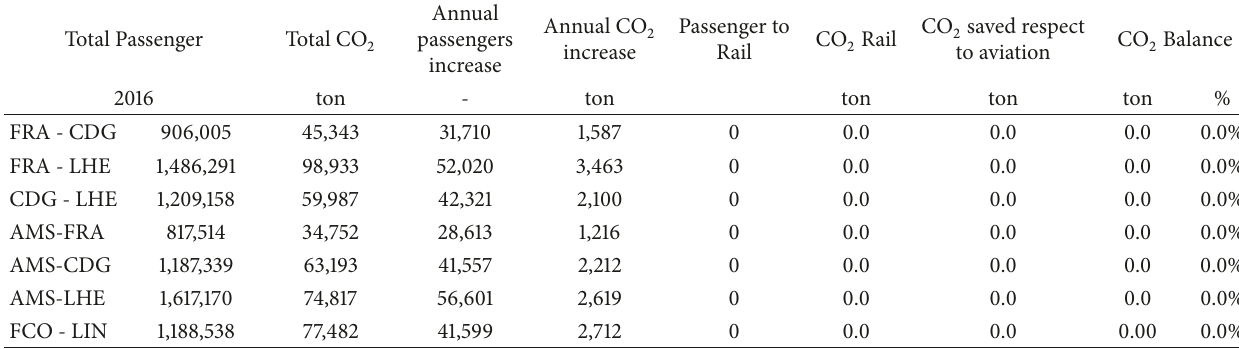
Table 9: BAU scenario with 3.5% annual growth and zero shifting between the modes.